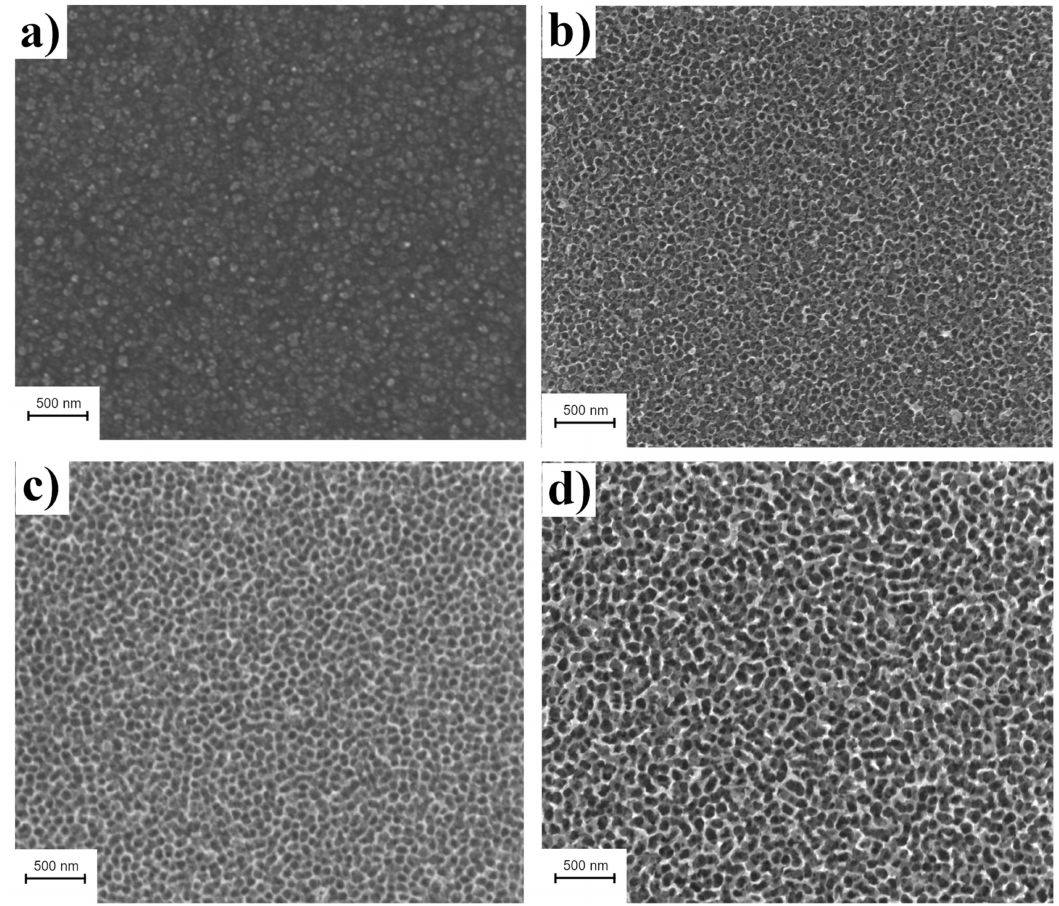
Figure 3. SEM micrographs of WO 3 nanopores array formed by anodization of W foil in 1 M H 2 SO 4 solution of 0.1 M NaF for 1 h at various potentials: ( a ) 20 V; ( b ) 30 V; ( c ) 40 V; and ( d ) 50